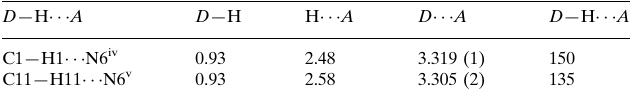
Hydrogen-bond geometry (A˚ , (cid:3)